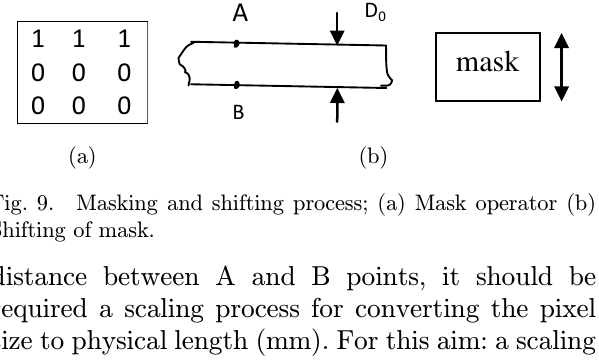
Fig. 6. The gelatin phantom with arti¯cial vein.